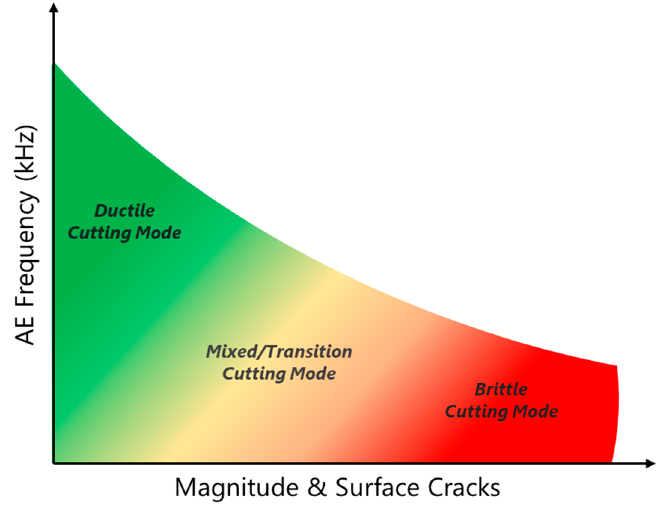
Figure 11. Qualitative illustration of the observed trend in gamma-titanium aluminide cutting mode.